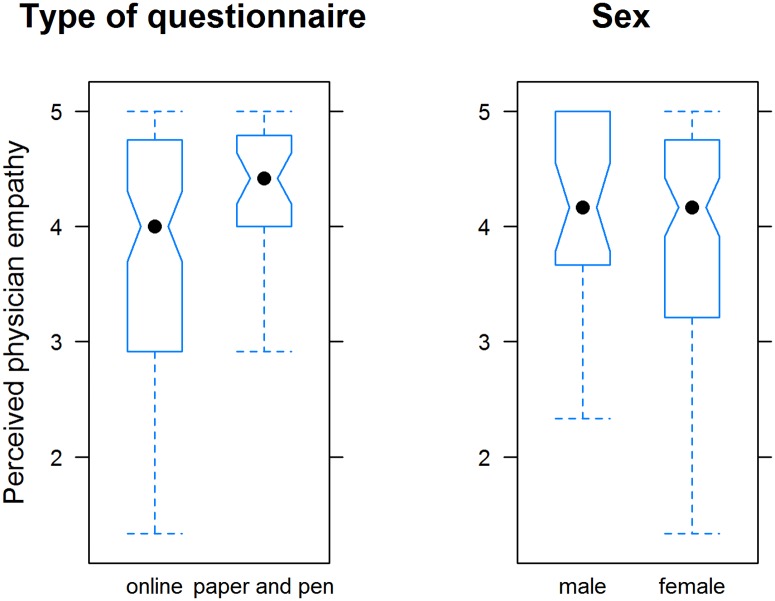
Perceived physician empathy as assessed by the Consultation and Relational Empathy (CARE) measure; Tukey’s box plots.Left: The questionnaire was administered as either an online or a paper-and-pen version; the difference was statistically significant (p <0.001; Mann-Whitney U test). Right: Sex of patients; no difference.